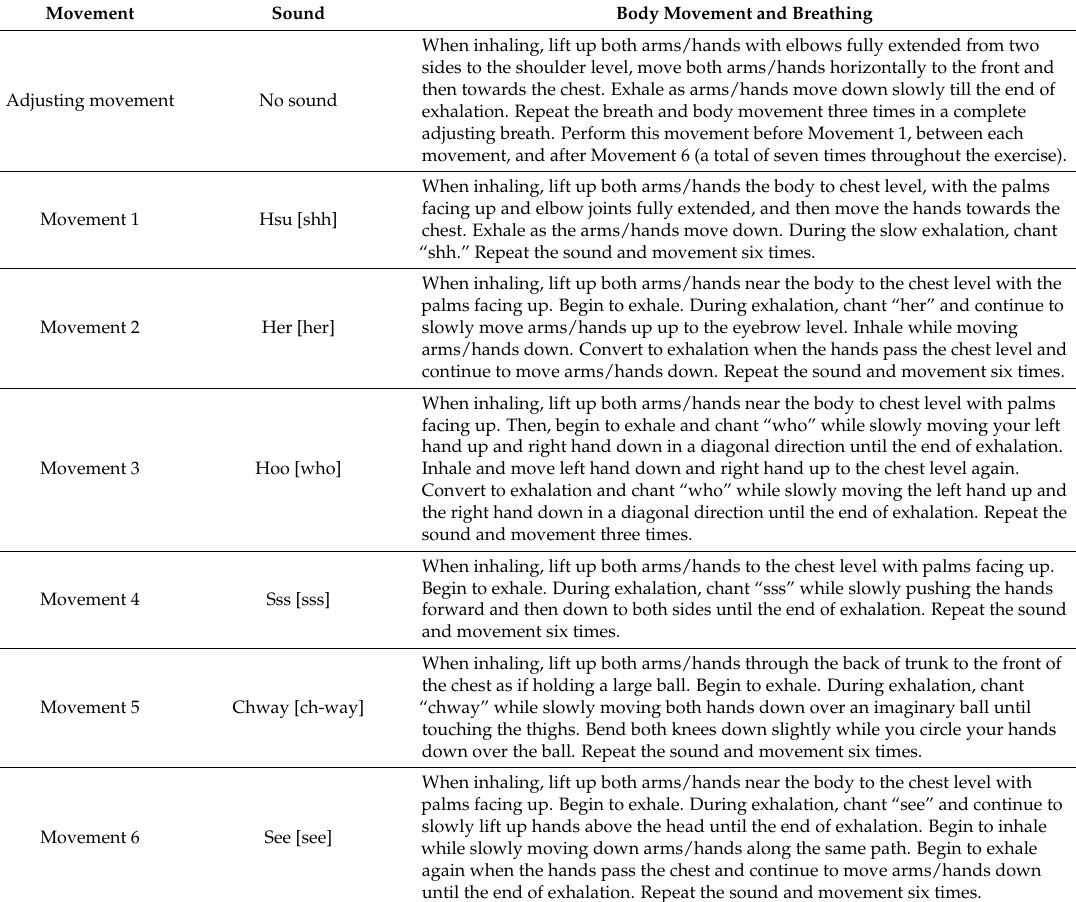
Table 1. Description of six-healing sounds Qigong